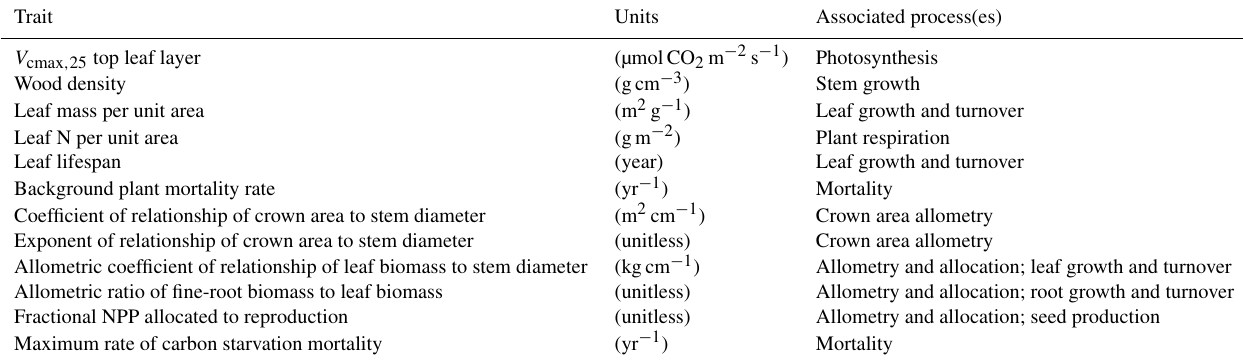
Table 1. Traits varied within each ensemble in order to define plant functional types, their units, and the process or processes (as diagrammed in Fig. 1) most closely associated with each trait.